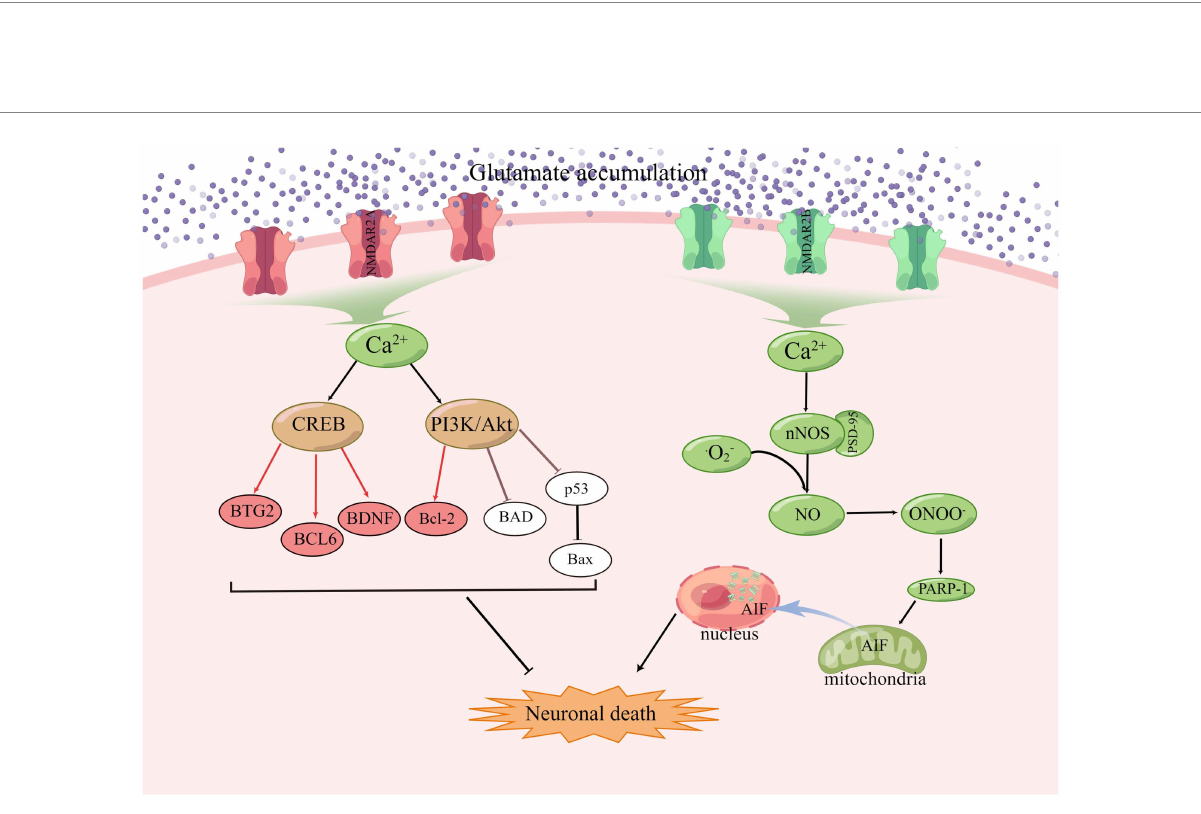
FIGURE 3 In ischaemic stroke, GluN2A and GluN2B play opposing roles, with GluN2B activation leading to excitotoxicity and apoptosis and GluN2A activation promoting cell